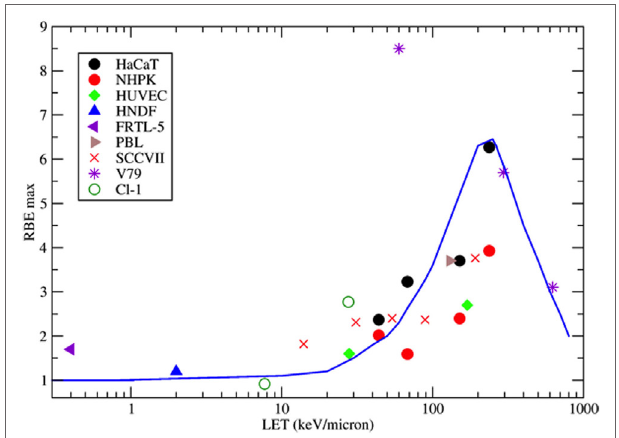
FiGURe 4 | Collection of measured relative biological effectiveness (RBE) data for the induction of MN per BN cell after exposure to protons, α -particles, or energetic heavy ions. RBE was calculated as the ratio of the initial slope of the dose-response curves for ions and photons as measured by the same authors. Different symbols refer to different cell types. HaCaT = spontaneously immortalized adult human keratinocytes (63); NHPK = normal human neonatal epidermal keratinocytes (63); HUVEC = human umbilical vein endothelial cells (67); HNDF = human neonatal dermal fibroblasts (59); FRTL-5 = Fischer rat thyroid cell line (60); PBL = human peripheral blood lymphocytes (61); SCCVIII = mouse squamous cell carcinoma (64); V79 = Chinese hamster fibroblasts (62); Cl-1 = Chinese hamster fibroblasts (46). The blue line is a guide for the eye.